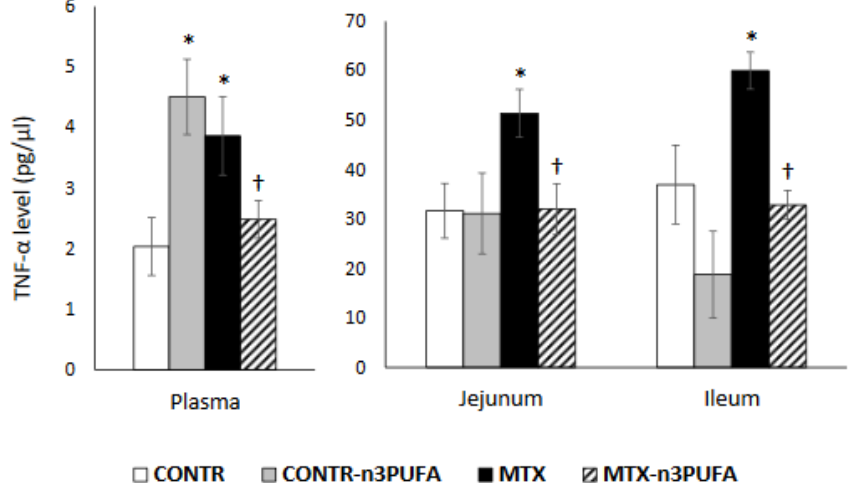
Figure 3. Changes in TNF- α levels in plasma and intestinal tissue during MTX induced intestinal damage and exposure to n-3 PUFAs. Enzyme-linked immunosorbent assay (ELISA) was used to determine TNF- α levels. Values are mean ± SEM. CONTR- control, MTX-methotrexate, n-3 PUFAs. * p < 0.05 all groups vs. CONTR rats, † p < 0.05 MTX-n-3 PUFAs vs. MTX rats.